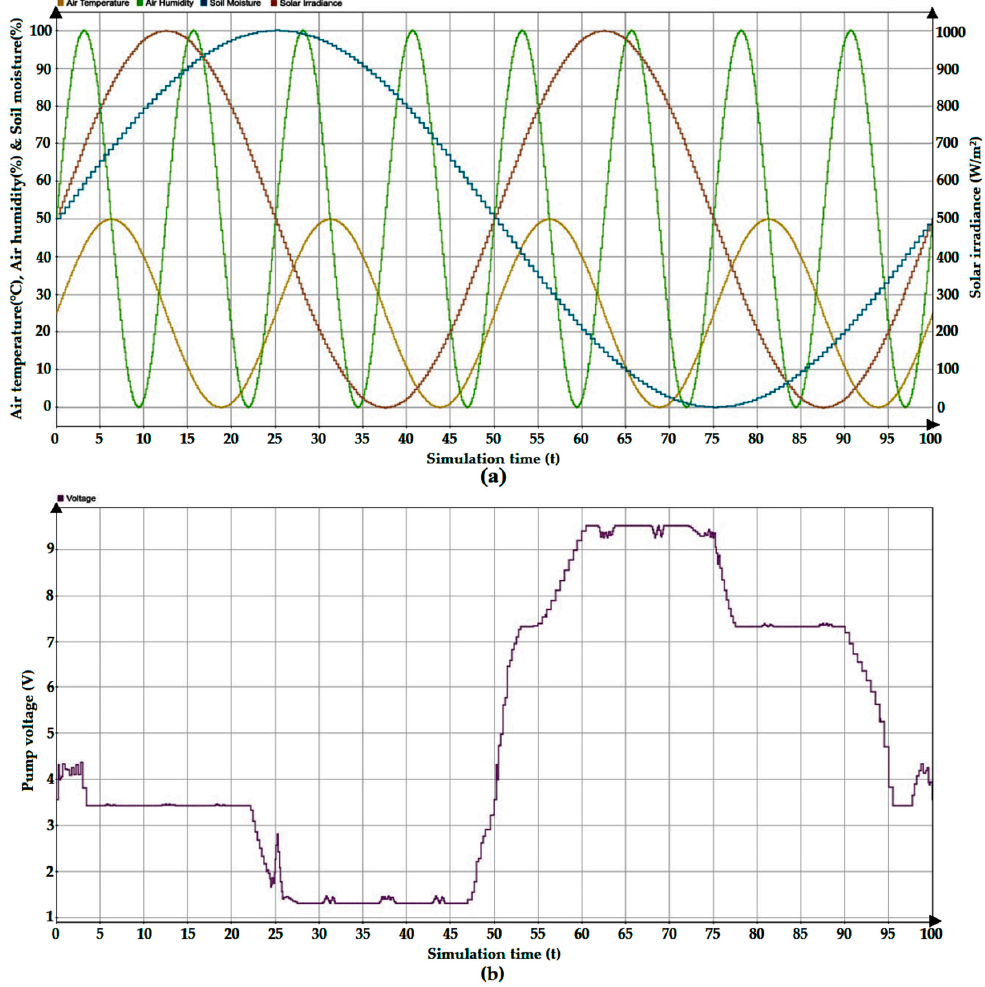
Figure 11. ( a ) Solar irradiance, air temperature, air humidity, and soil moisture input graph; ( b ) voltage output graph.